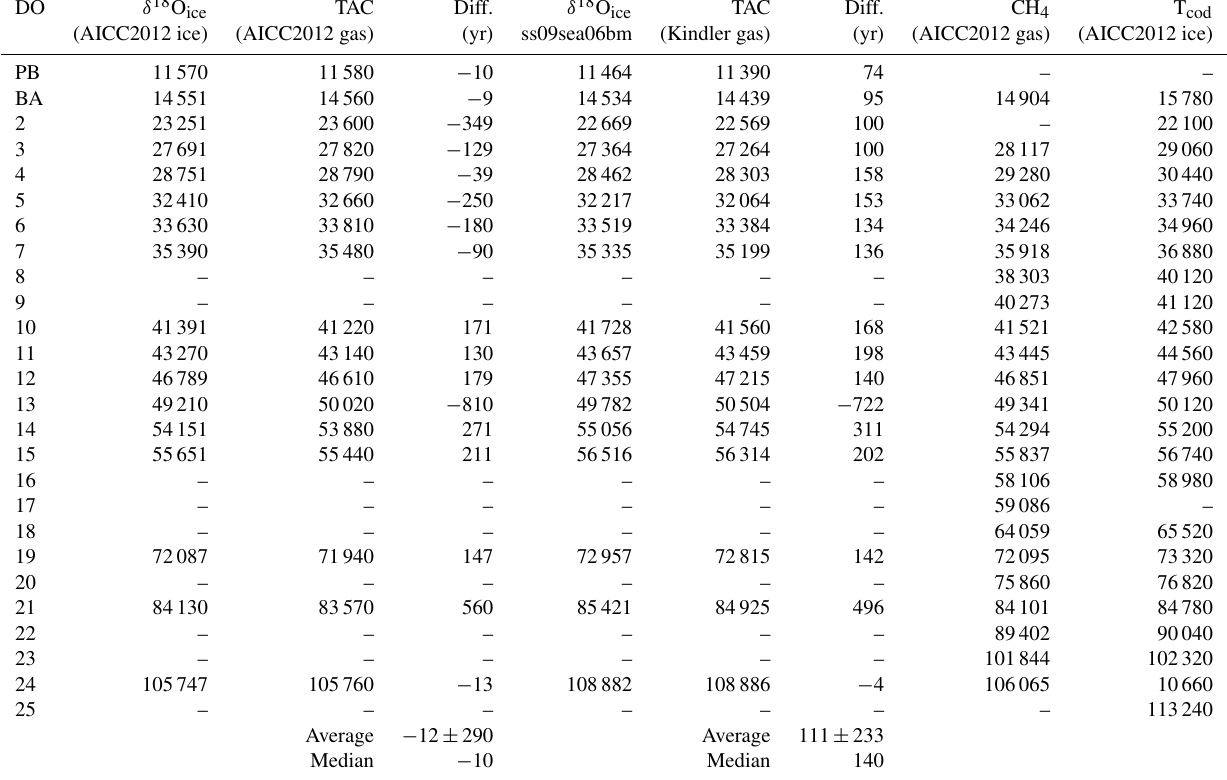
Table 4. Timing of the DO events and related features. The time value in δ 18 O ice denotes the maximum of the rise in δ 18 O ice on the AICC2012 ice age scale, determined visually. The time point in TAC is the time of the minimum, found with the method described in Sect. 4.3.2. On average the δ 18 O ice rise is younger by − 12 ± 290 years with a median of − 10 years on the AICC2012 age scale. The corresponding values on the sso9sea06bm ice age scale and the gas age scale published by Kindler et al. (2014) are also shown in the second block of the table. On average the δ 18 O ice rise is older by 111 ± 233 years with a median of 140 years on these age scales. The third block shows the timing of the onset in CH 4 used for the stacking in Fig. 10a on the AICC2012 gas age scale (Veres et al., 2013). In the forth block, the onsets in bubble close-off temperature T cod used for the stacking in Fig. 10b on the AICC2012 ice age scale are displayed.